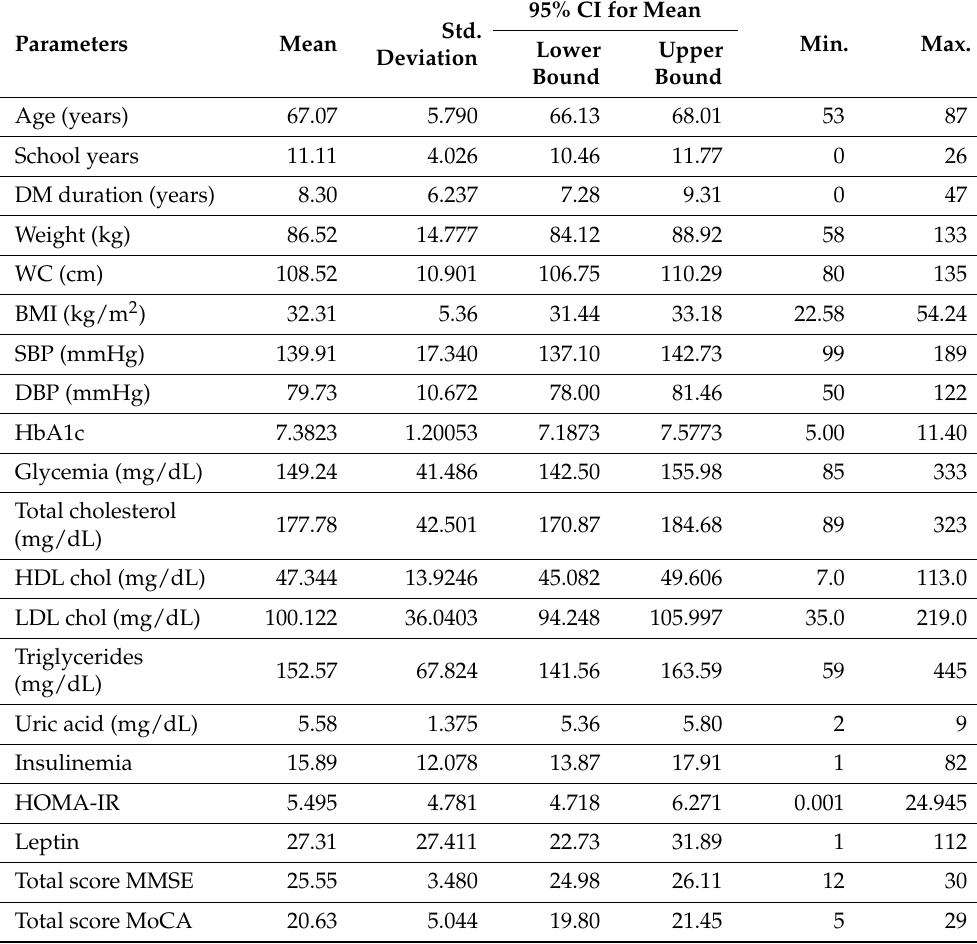
Table 1. Characteristics of the study